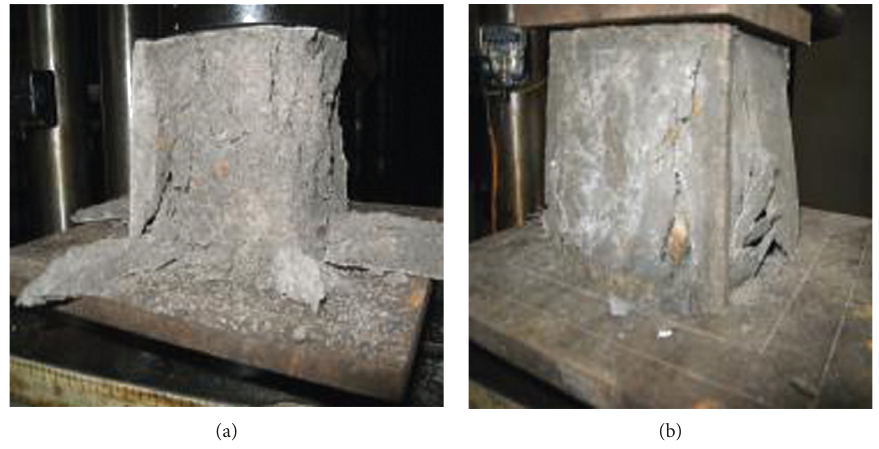
Figure 3: Compression failure true thickness. (a) Reference concrete. (b) Steel fiber-silica fume shotcrete.